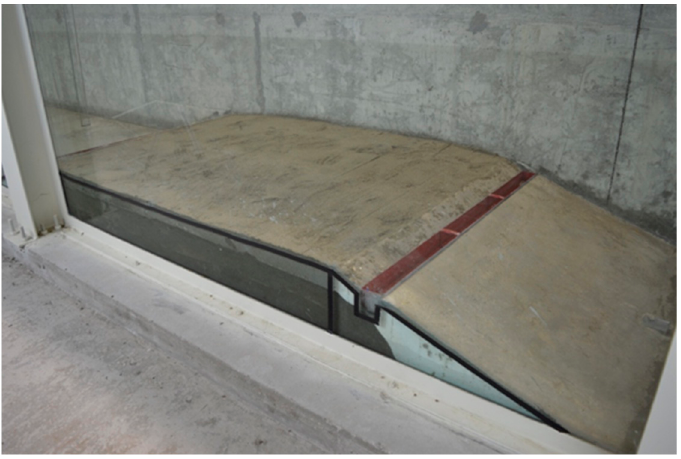
Figure 4. Horizontal sand bed layout.